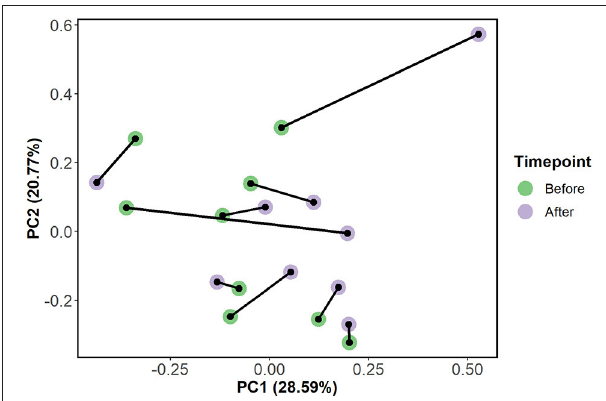
FIGURE 2 | A principal component analysis (PCA) plot of the plasma metabolites concentration in the subjects ( n = 10) before and after TC intervention. Samples are colored based on the time-point (before or after intervention) and samples from the same subject are connected by a black